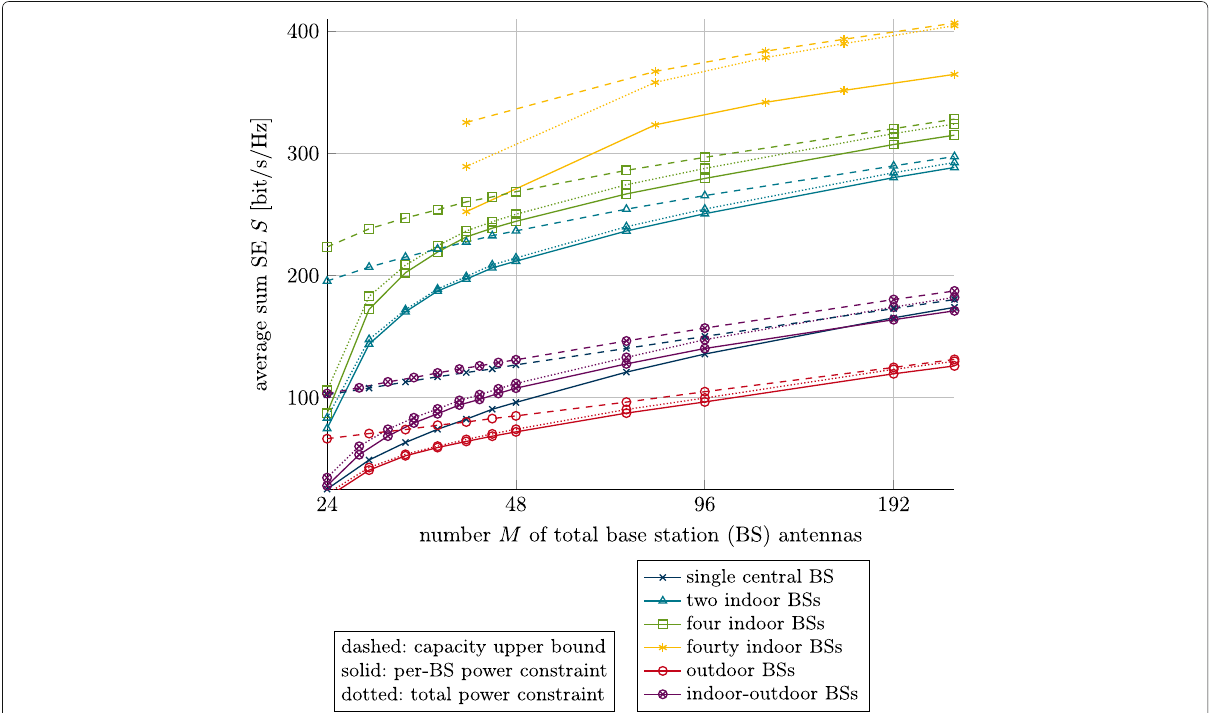
Fig. 5 Comparison to capacity. Average sum SEs of network MIMO for Gaussian